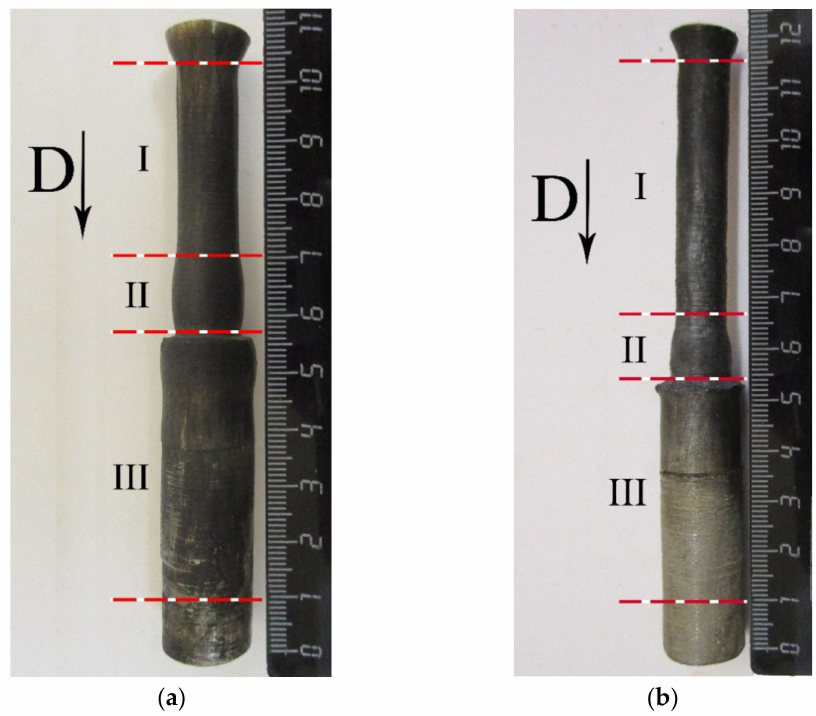
Figure 4. Photograph of ampoules after SWE and segments: ( a ) ampoule No. 1; ( b ) ampoule No. 2.